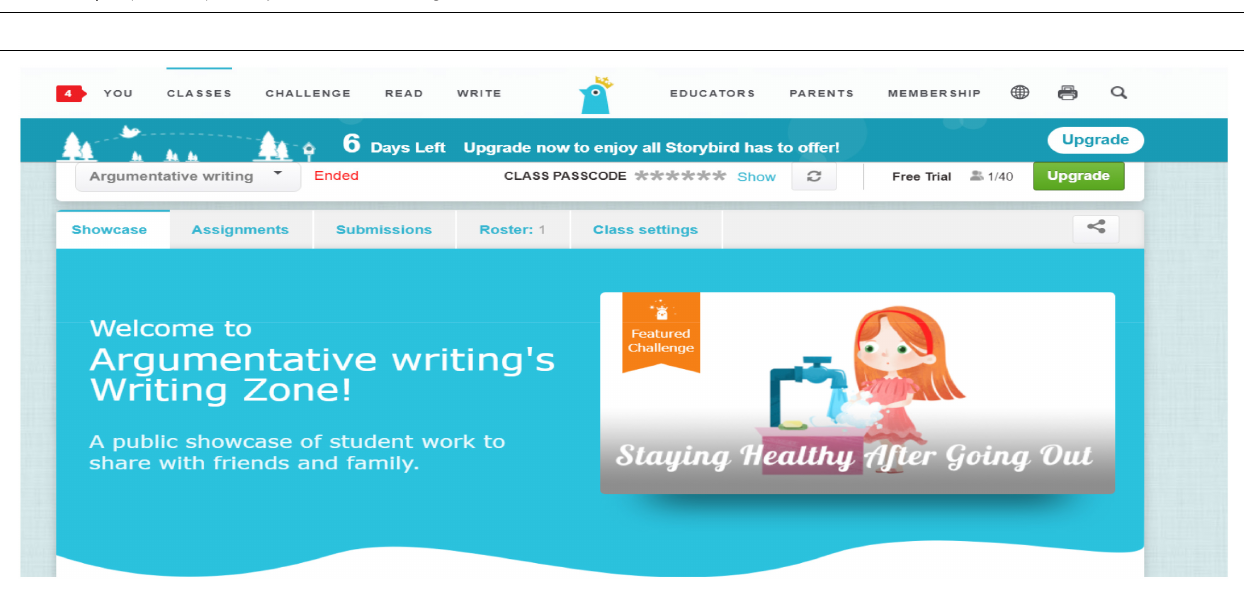
FIGURE 1 | Sequential explanatory mixed methods design.